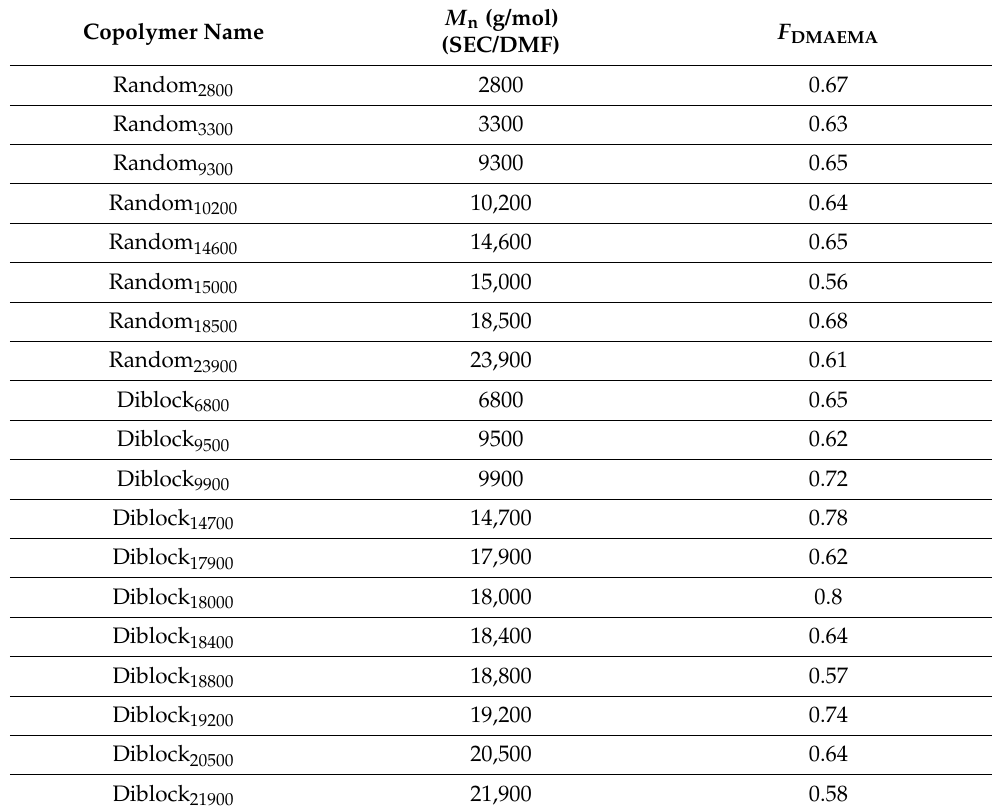
Table 1. Characteristics of the Random and Diblock copolymers with M n the number average molecular weight and F DMAEMA the DMAEMA molar ratio in the final copolymer. Copolymer